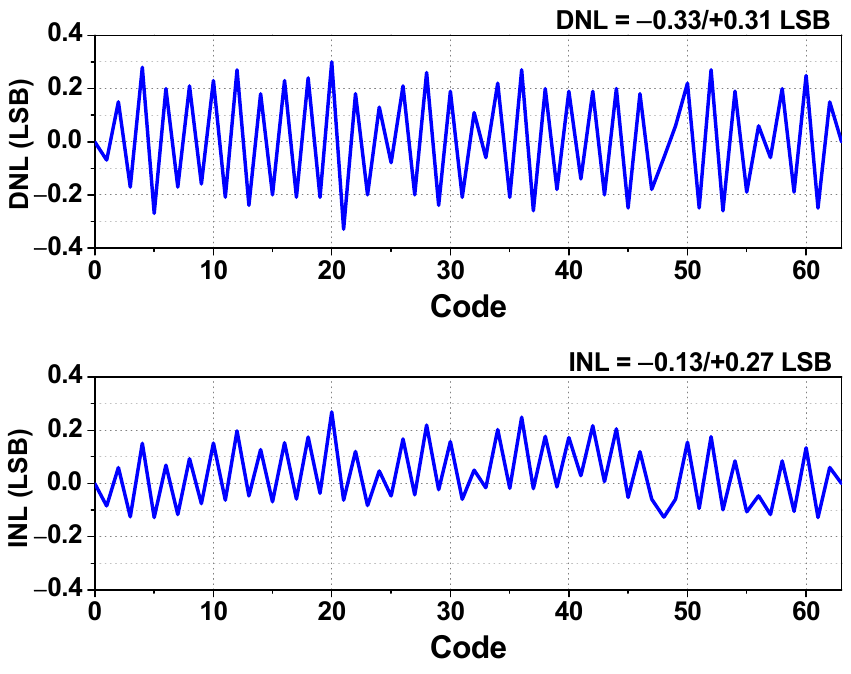
Figure 11. Measured DNL and INL. The measured signal-to-noise and distortion ratio (SNDR) and spurious-free dynamic range (SFDR) results of five samples with a 349.74 MHz input at a 700 MS/s are shown in Figure 12. The SNDR and SFDR for the five samples were above 34 dB and 47 dB, respectively. Although the number of measurement samples was rather limited, these measurement results indirectly showed that the proposed ADC could achieve good perfor- mance without an offset calibration.